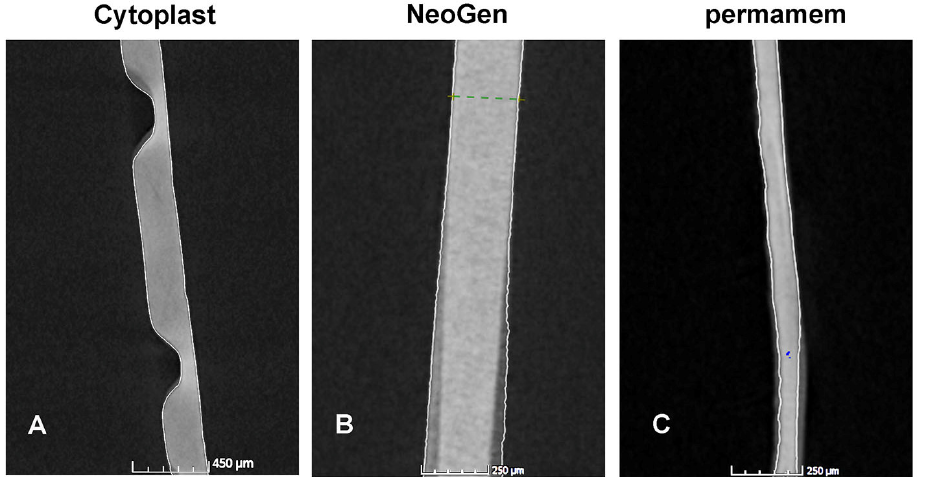
Figure 5. Nano-CT examination of the tested membranes. Representative axial sections from textured and non-textured membranes. ( A ) Cytoplast TM TXT-200 textured membrane with hexagonal shaped indentations on the soft-tissue site and flap surface in the bone tissue site; ( B ) NeoGen ® : the thickest non-textured membrane; ( C ) permamem ® : the thinnest non-textured membrane.